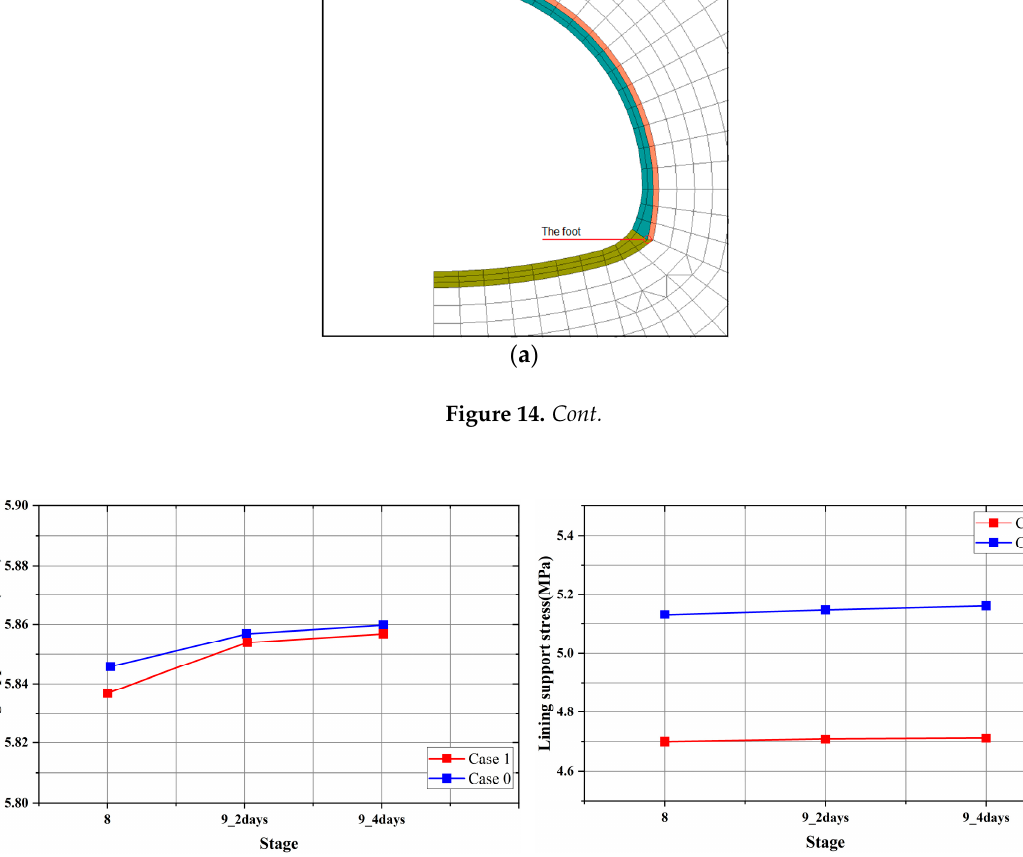
Figure 14. The minor principal stress. ( a ) Monitoring lining points plot; ( b ) the minor principal stress of the roof; ( c ) the minor principal stress of the foot.